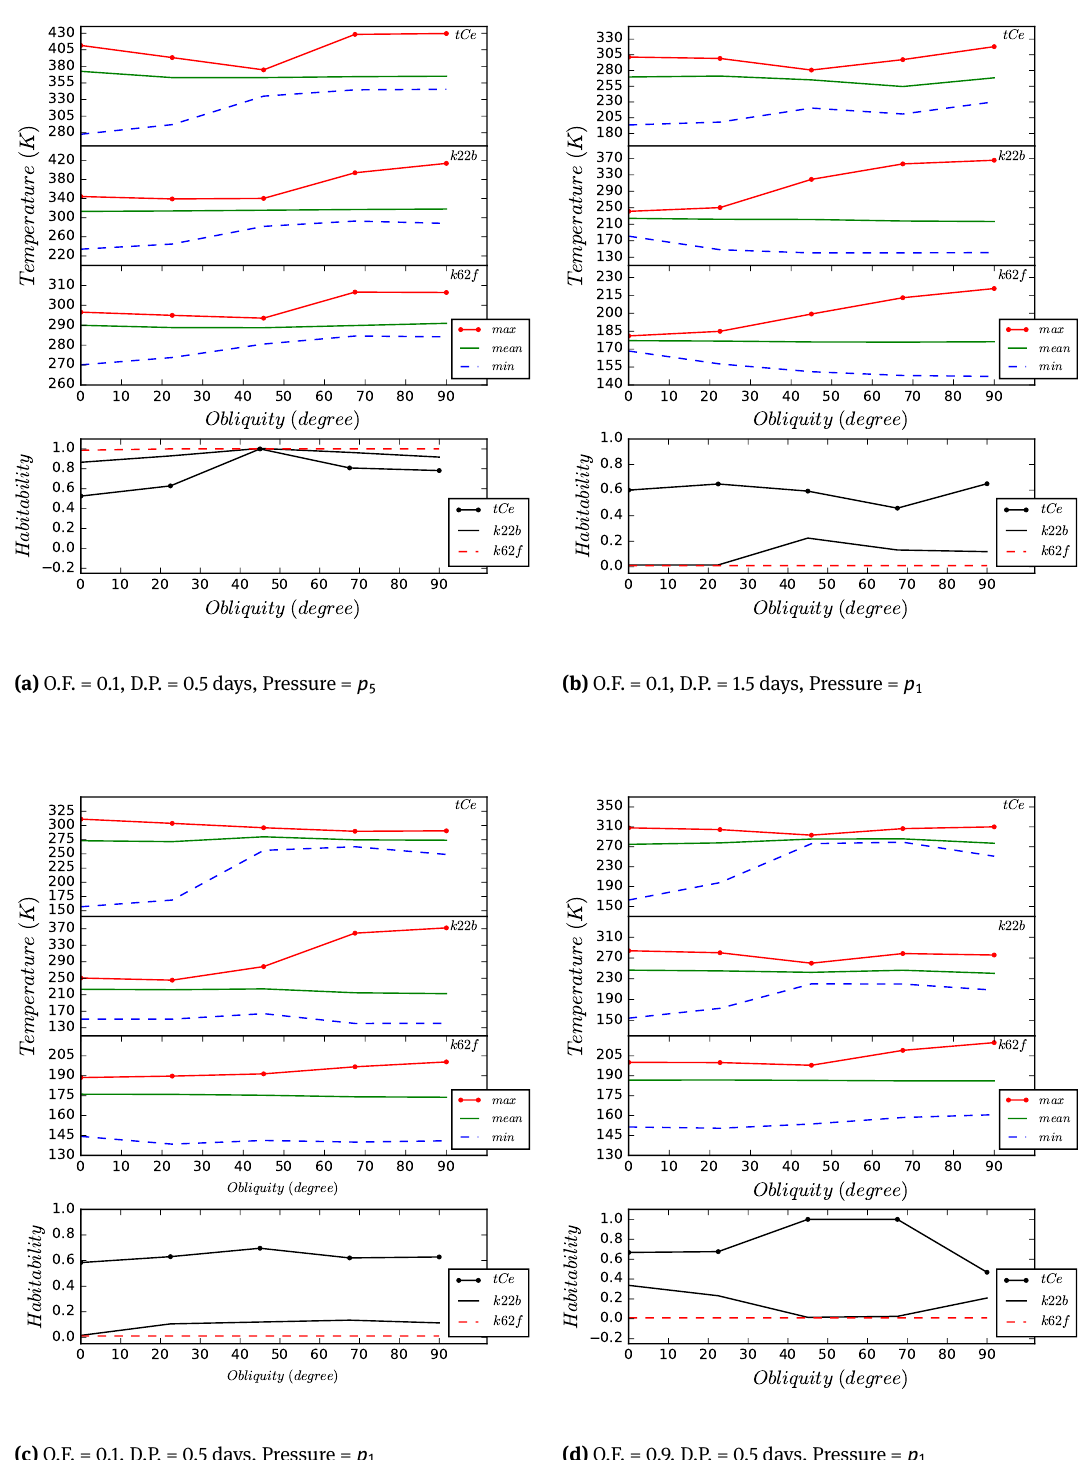
(c) O.F. = 0.1, D.P. = 0.5 days, Pressure = p 1 (d) O.F. = 0.9, D.P. = 0.5 days, Pressure = p 1 Figure 3. Spin obliquity varies; for planet τ Ceti e (tCe), Kepler-22b (k22b) p 1 = 0.1 atm , p 5 = 1.3 atm ; and for Kepler-62f (k62f) p 1 = 0.5 atm , p 5 = 4.5 atm